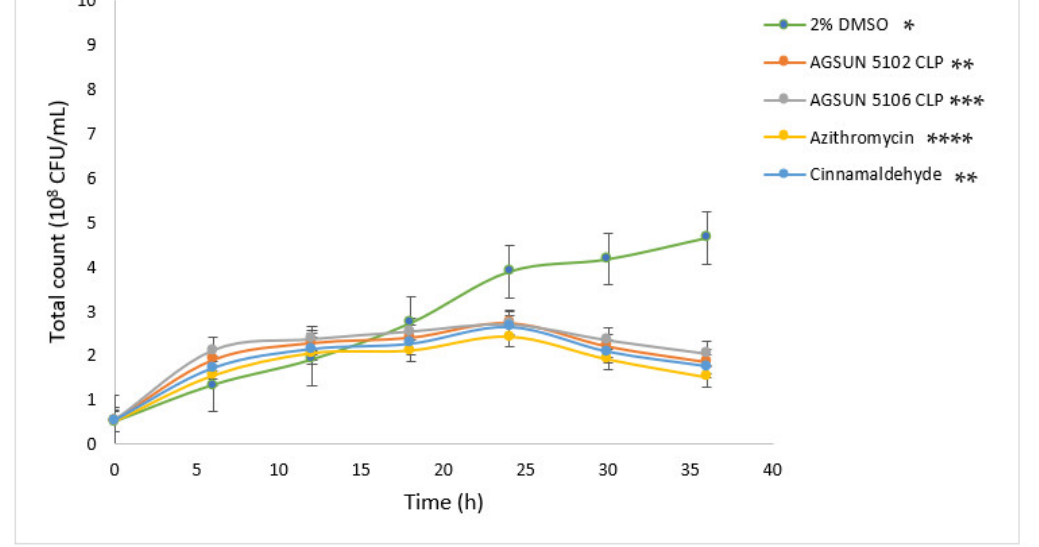
Figure 2. Growth curves of C. violaceum supplemented with different treatments at 37 °C for 36 h. The growth profiles are statistical difference at p -value ≤ 0.05 with *, **, *** and **** denoting significant differences between the treatments.